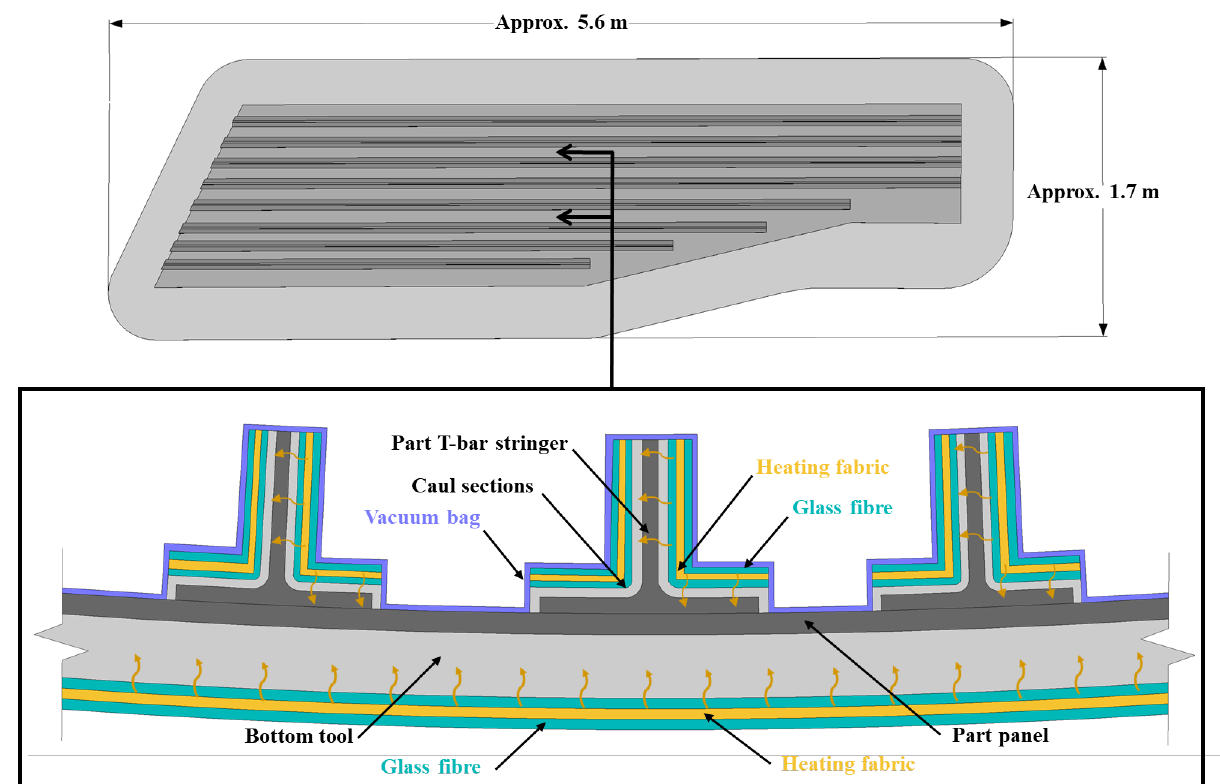
Figure 3: An illustration of heating fabric integration with the bottom tool and stringers.